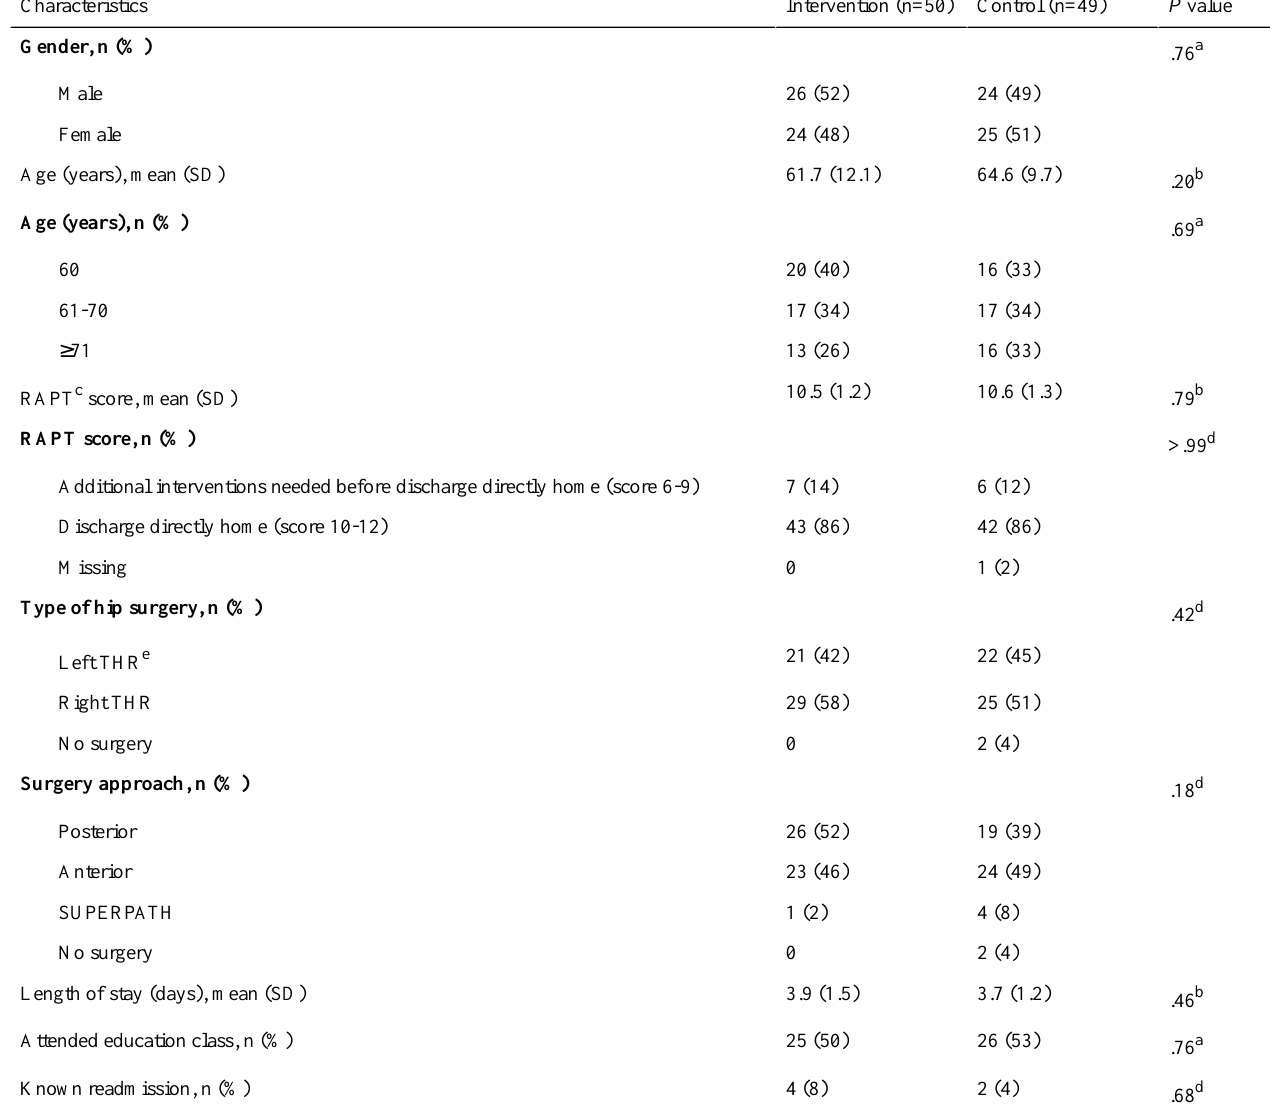
Table 1. Baseline demographics of participants in the intervention and control